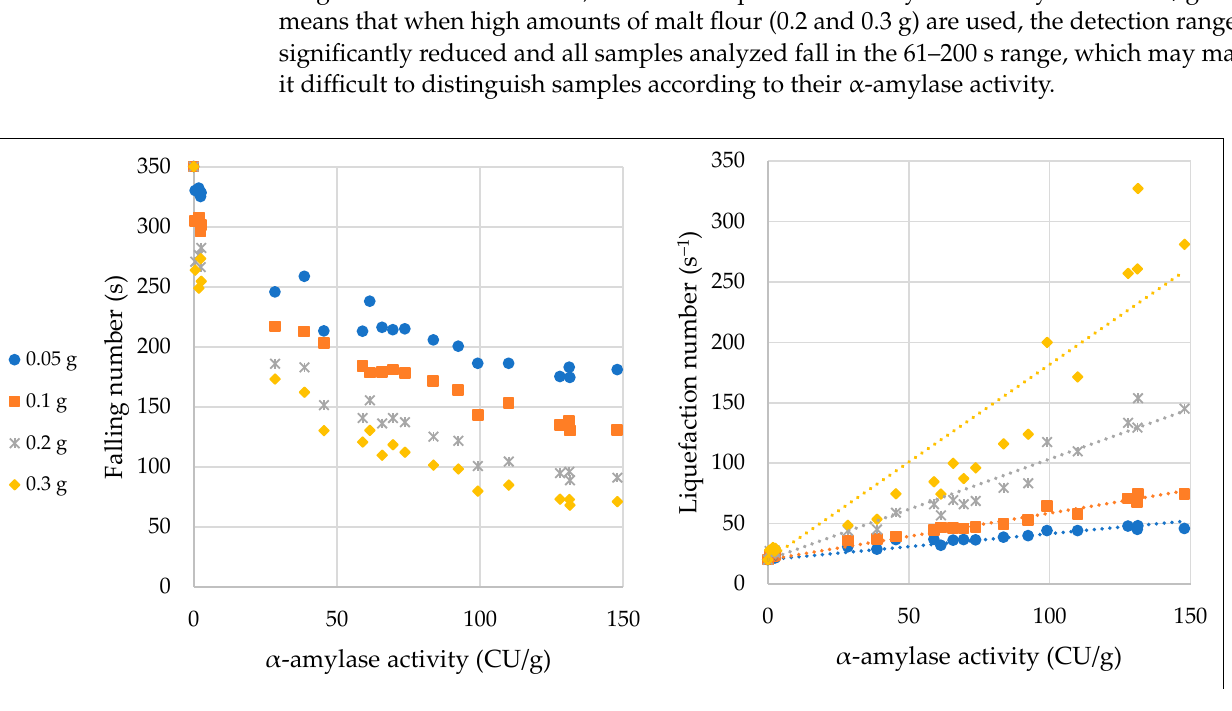
Figure 1. Influence of the addition of different amounts of malt flour on the Falling Number and Figure 1. In fl uence of the addition of di ff erent amounts of malt fl our on the Falling Number and Liquefaction Number (lines indicate a linear Liquefaction Number (lines indicate a linear trend).